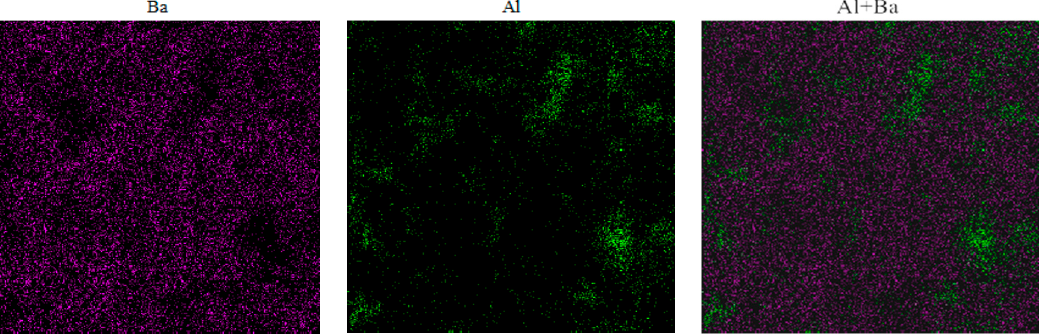
Figure 3. The EDS of Al, Ba and Al + Ba elemental in f Al